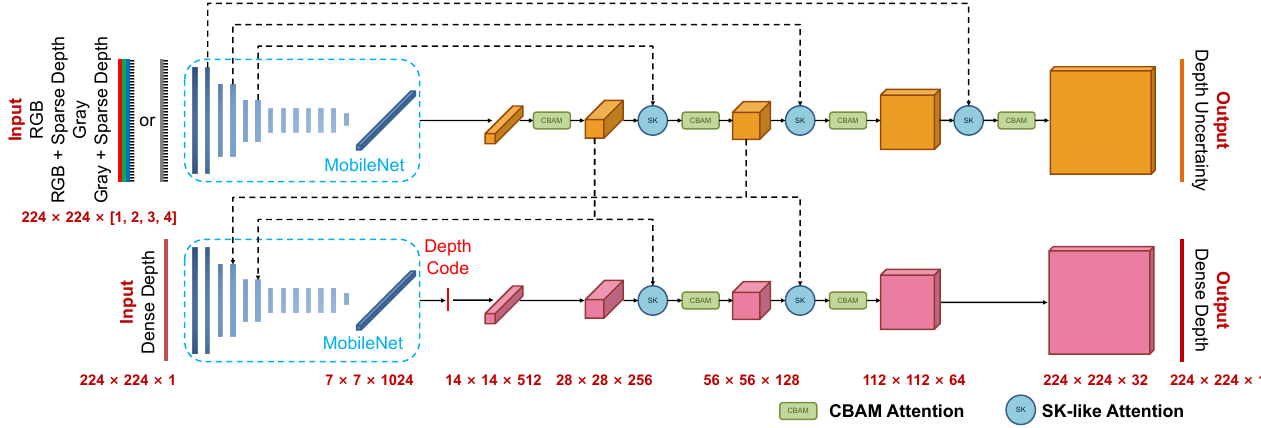
Figure 3. The architecture of our proposed light-weight network with attention mechanisms for uncertainty-aware dense depth estimation and completion. The network supports multiple input modalities: RGB, RGB + Sparse Depth, Gray, and Gray + Sparse Depth. The top stream is a UNet network to extract input features and outputs the dense depth uncertainty map. The bottom stream is the CVAE network conditioned on the features from the above UNet and predicts the dense depth